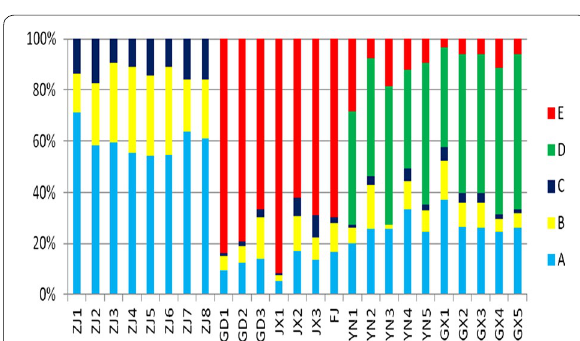
Fig. 4 Content percentage of 5 respectively compounds in Den- drobium officinale , including Apigenin-6,8-di-C-β- d -glucoside (A), Apigenin-6-C-β- d - xyloside-8-c-β- d -glucoside (B), Schaftoside (C), Isoviolanthin (D), Rutin